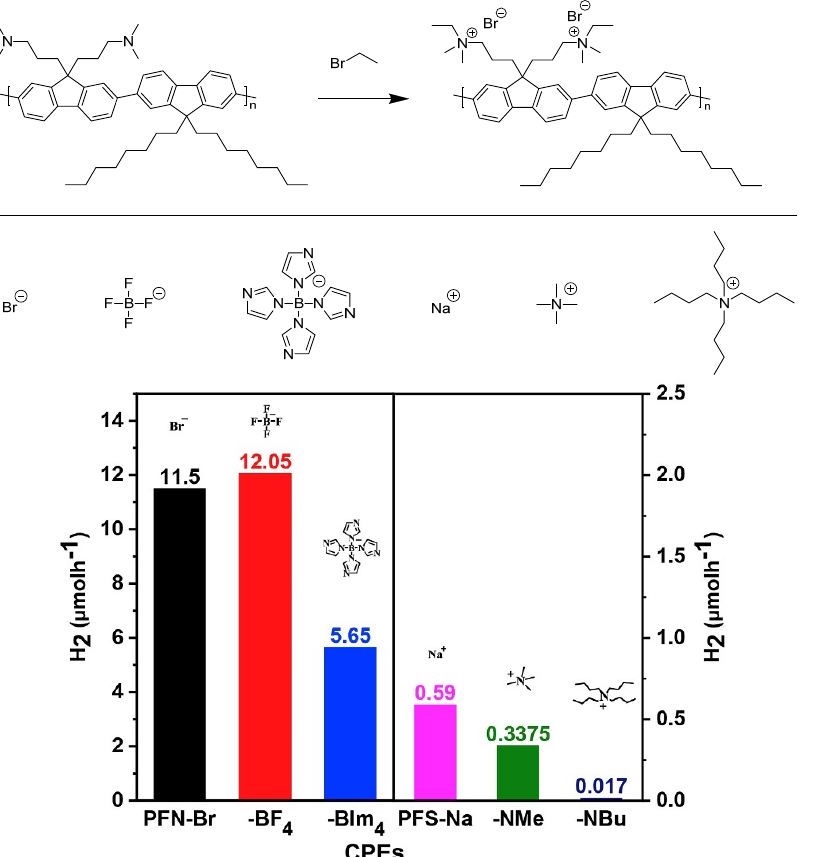
Figure 20. Top: Synthesis of a poly(fluorene) CPE from the non-ionic precursor and counter ions used in the study. Bottom: Rates of photocatalytic sacrificial hydrogen production for CPEs with different anionic and cationic counterions [Reprinted from Nano Energy, 60, Z. Hu et al., Highly efficient photocatalytic hydrogen evolution from water-soluble conjugated polyelectrolytes, 775–783, Copyright 2019, with permission from Elsevier] [112].